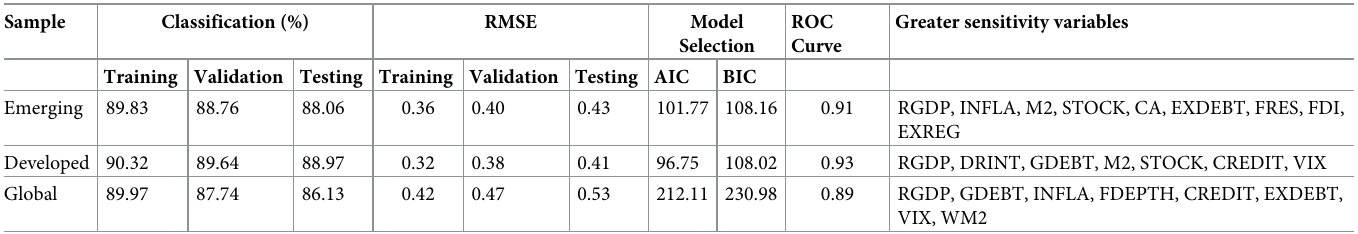
Table 10. Results of accuracy evaluation for SS3.